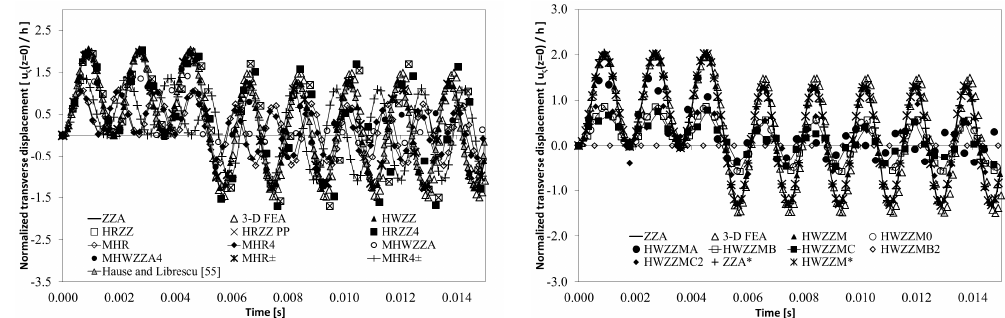
Figure 11. Case i1: Normalized transverse displacement of a simply supported sandwich plate under a step blast pulse loading ( L x/ h = 20.8696).